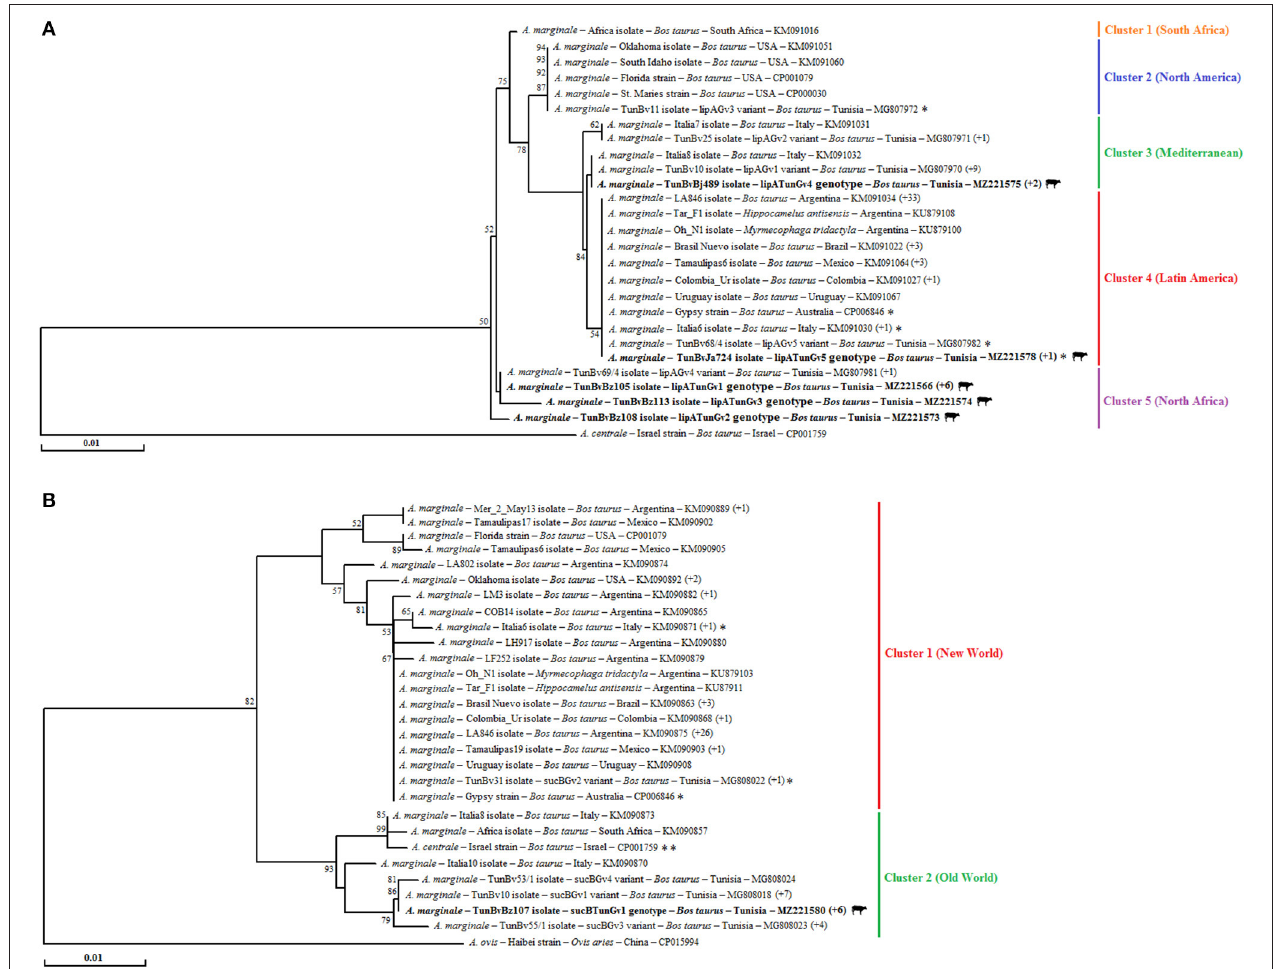
FIGURE 2 | Phylogenetic tree showing all Anaplasma marginale genetic variants based on multiple alignment of lipA (A) and sucB (B) partial nucleotide sequences (501 and 681 bp, respectively) using the “neighbor-joining” method. The numbers related to the nodes represent robustness rates over 1,000 iterations supporting the nodes (only rates > 50% are shown). The host, strain or isolate, country of origin, and GenBank accession number are indicated. The sequences of A. marginale newly obtained in the present study are in bold and marked with a bovine picture. Sequences that are not classified into their appropriate geographic regions represented by clusters are indicated with an asterisk. The numbers that are in parentheses at the end of some sequences represent isolates or strains that are represented by an identical sequence from the isolate or strain present in the tree.